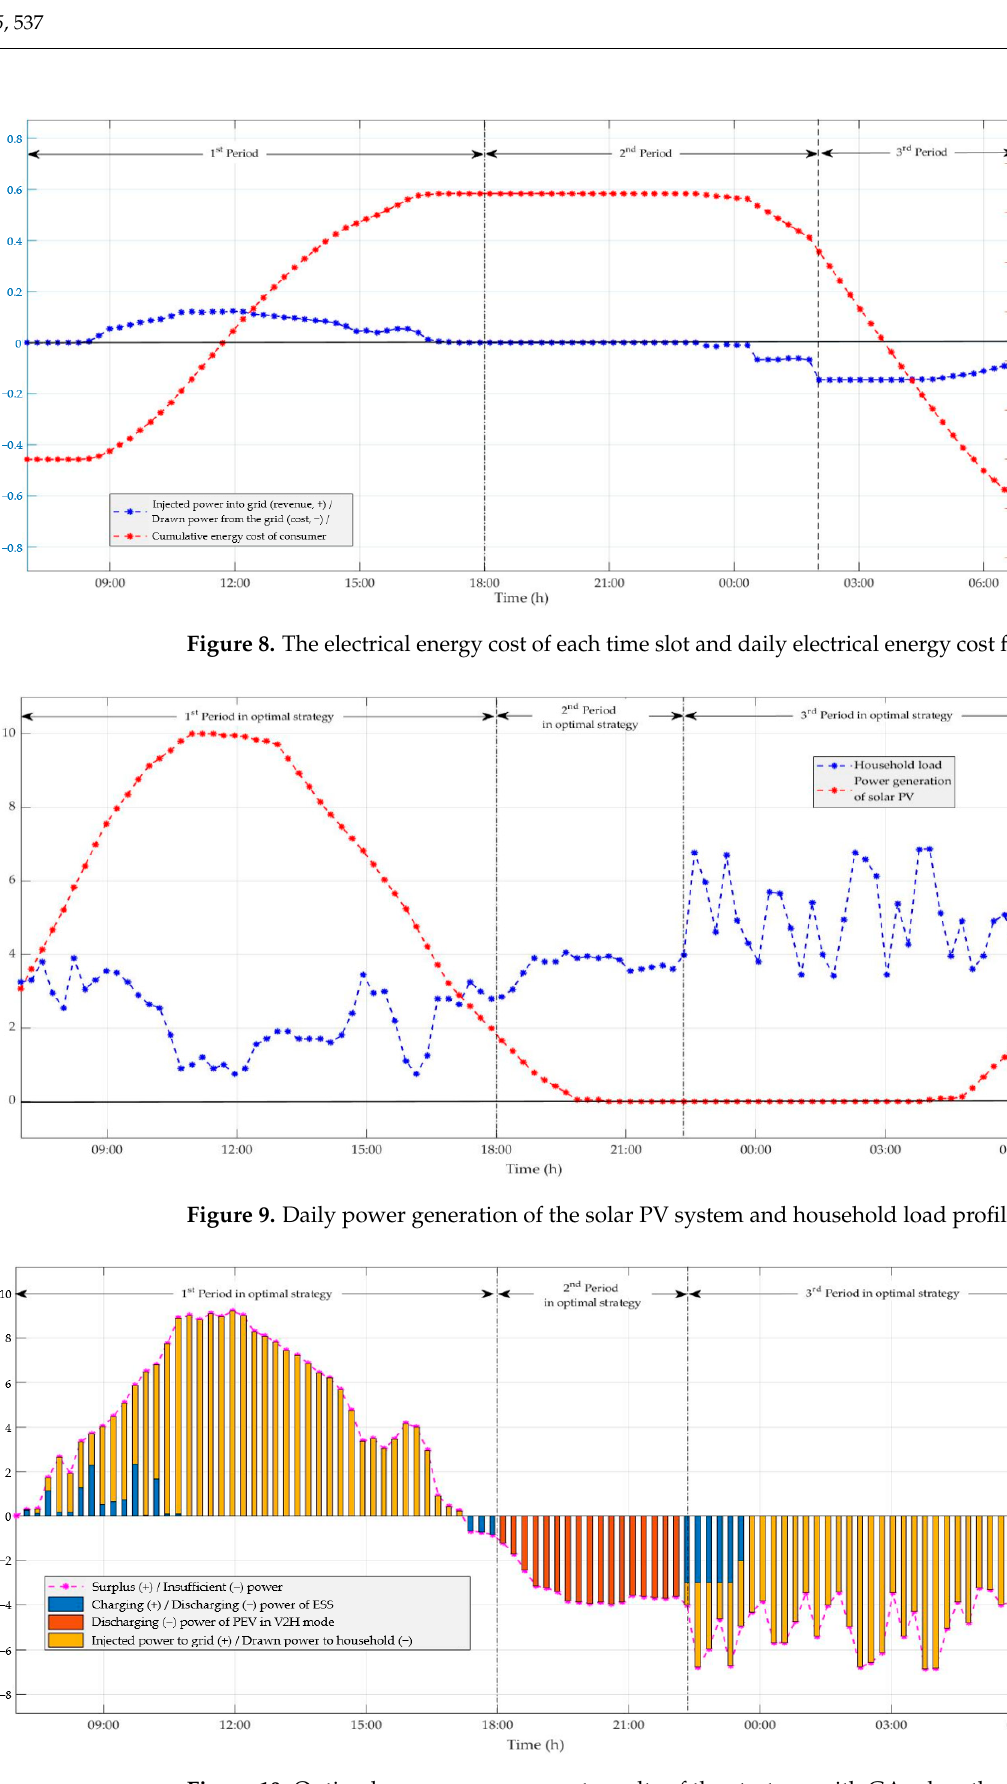
Figure 10. Optimal energy management results of the strategy with GA when there is surplus and insufficient power in a household in each time slot.